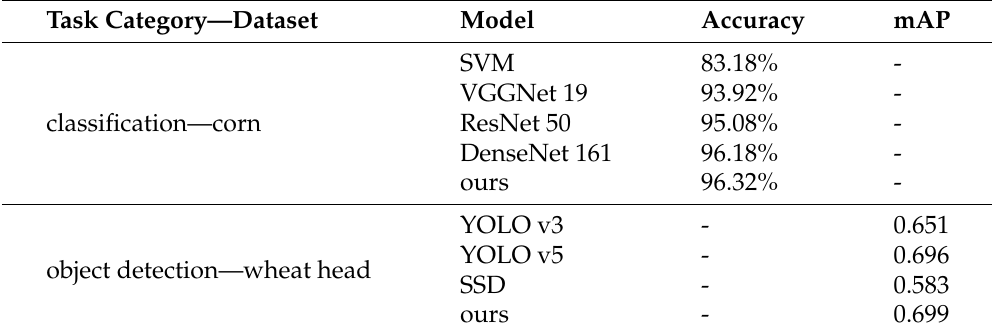
Table 9. Validation results of feature extraction capability for small-scale objects.